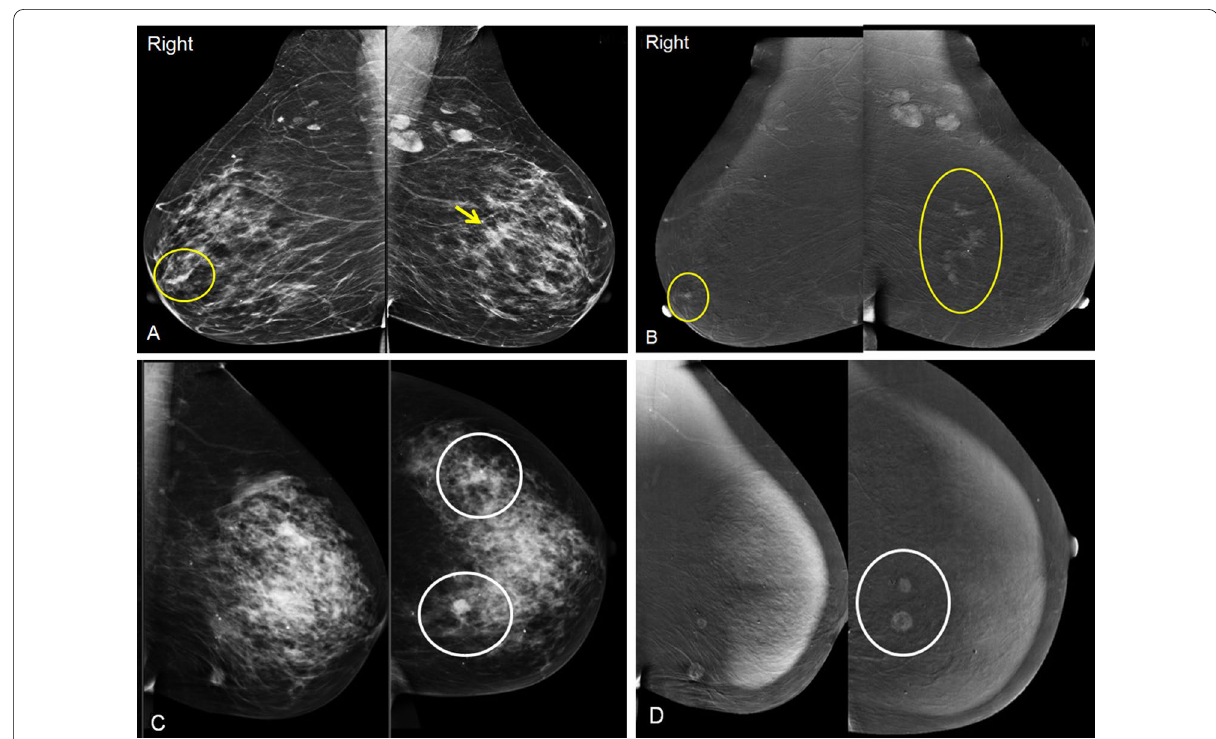
Fig. 3 Two cases: the first case was a 35-year-old female presented with left breast palpable lump. Biopsy revealed bilateral invasive ductal carcinoma. a Digital mammogram of both breasts MLO views that showed dense breasts with left breast deep central spiculated mass (BI-RADS 5) (arrow) and right breast retroareolar probably benign (BI-RADS 3) linear asymmetry (circle). b CEM of both breasts MLO views showed left breast mass that was seen on the mammogram and additional newly detected multiple adherent masses (BI-RADS 5- multifocal carcinoma) (circle). The right breast also presented retroareolar ill-defined focal nodule of contrast uptake corresponding to the linear opacity that was seen on the mammogram (BI-RADS 4 proved to be a contra-lateral carcinoma) (circle). The carcinomas were more obvious at the CEM. The second case was a 48-year-old high-risk female that needed a screening mammogram. Biopsy revealed left breast invasive ductal carcinoma. c Left-sided digital mammogram CC and MLO views that showed dense breast with upper outer and lower inner two ill-defined suspicious focal masses (circles). d CEM of the left breast confirmed the malignant suspicion of the left lower mass as it presented rim contrast uptake, moreover another similar focus was also noted nearby (i.e. multifocal not a unifocal carcinoma) (circle). The upper outer mass previously noted on the mammogram showed no contrast uptake (proved to be benign cyst by complementary ultrasound). CEM not only detected the breast masses, but also estimated the accurate extension of the cancer in spite of the high density of the breast